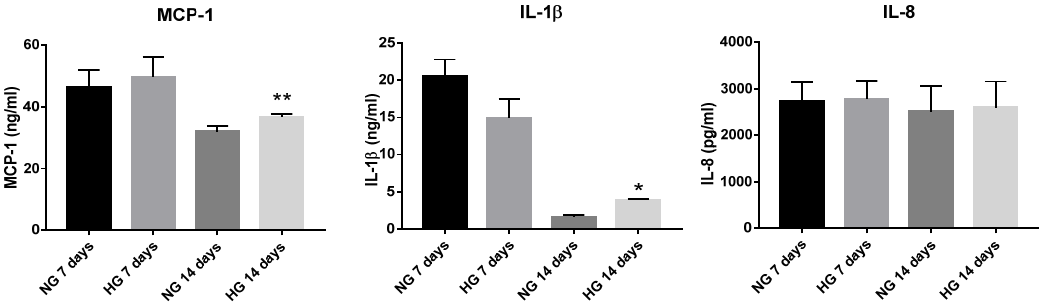
Figure 3. Soluble MCP-1, Il-1 β and IL-8 protein secreted in the conditioned media by valvular cells from 3D-construct exposed to NG or HG conditions, as determined by enzyme-linked immunosorbent assay (ELISA). N = 3, * p < 0.05, ** p <